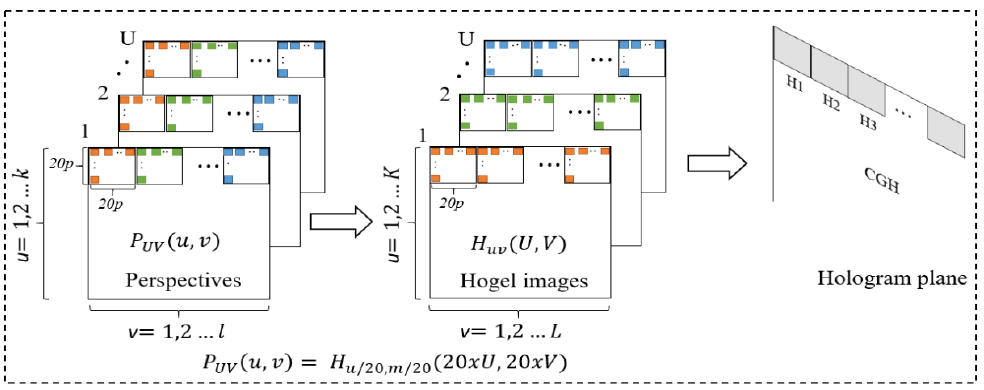
Figure 4. Proposed pixel re-arrangement algorithm from captured perspectives.